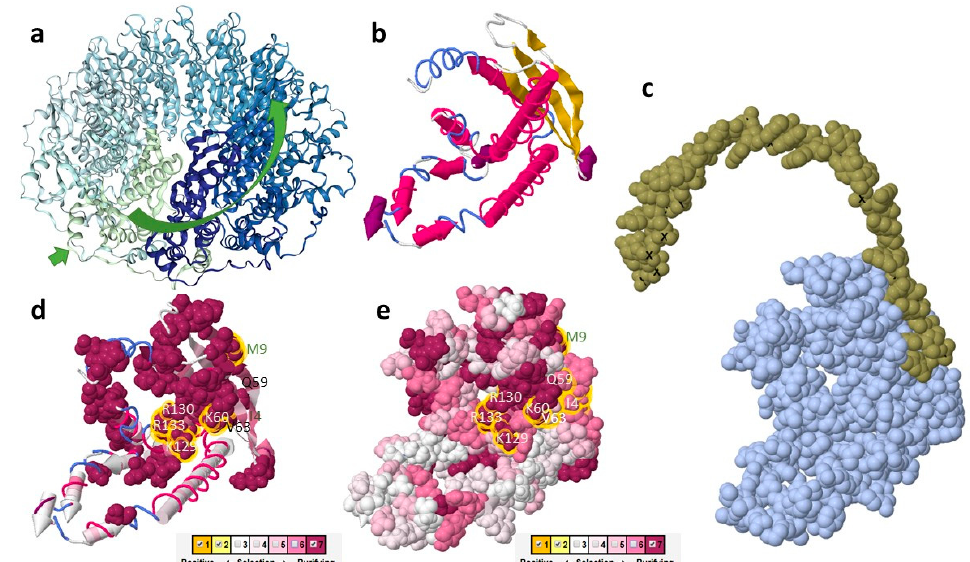
Figure 4. Three-dimensional representation of the structure predicted by I-Tasser integrated with Selecton results; ( a ) structure of human RAD52 is reported with the DNA binding groove evidenced and chains represented in different colors; ( b ) structure predicted by I-Tasser for the reference sequence used in the Selecton analysis; ( c ) DNA binding site as predicted by I-Tasser; ( d ) Selecton results in the M8 model reported on the predicted structure, 3D structures are represented as cartoons with only strongly negatively selected sites highlighted. DNA binding AA is highlighted with yellow halos; ( e ) Selecton results in the M8 model reported on the predicted structure, 3D structures are represented as spacefill. DNA binding AA are highlighted with yellow halos.